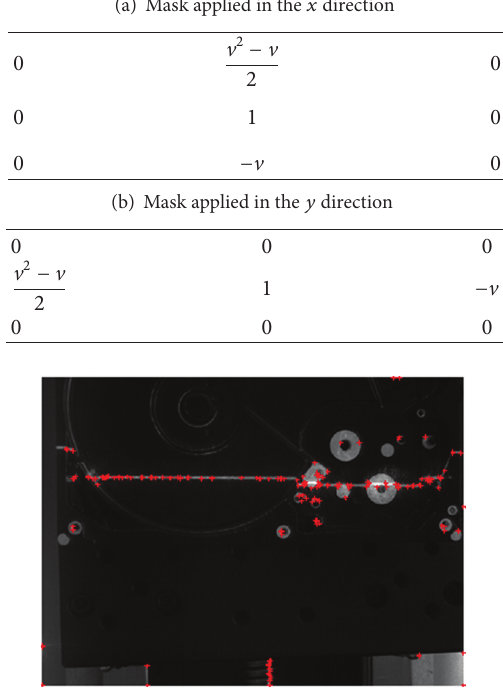
Table 1: Fractional differentiation mask applied in the 𝑥 direction shown in (a) and 𝑦 direction shown in (b).